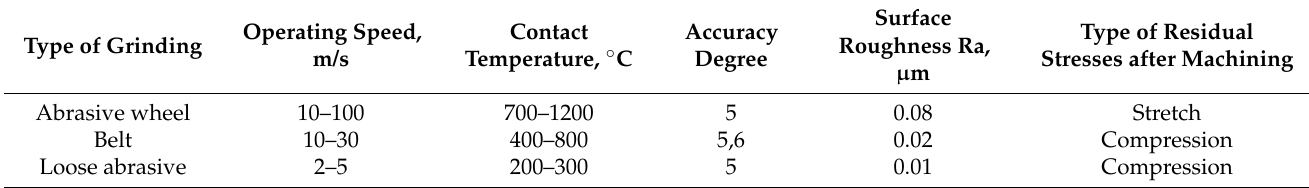
Table 1. A comparison of belt grinding with wheel and loose abrasive